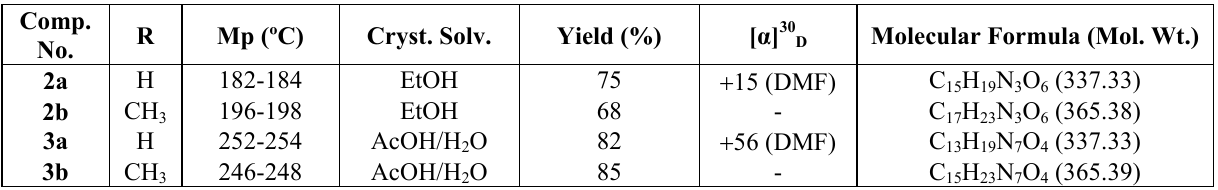
Table 1. Melting points, crystallization solvents, yields, molecular formulae and molecular weights of compounds 2a,b and 3a,b .